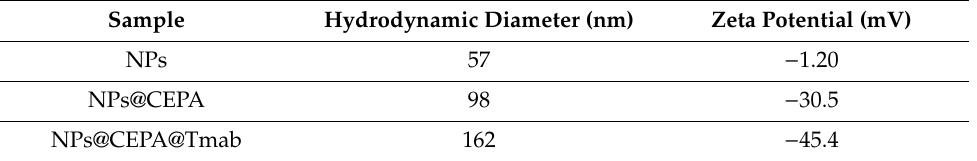
Figure 2. TEM image and NPs size distribution of ( a ) as-synthesizes SPIONs, ( b ) SPIONs functionalized with 3-phosophonopropionic acid, ( c ) SPIONs functionalized with trastuzumab, and ( d ) histograms based on TEM images (Scale bar: 50 nm). Table 1. Values of average hydrodynamic diameter and zeta